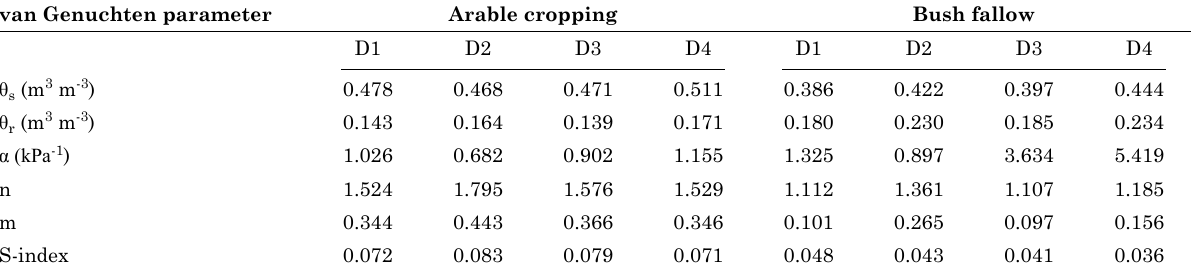
Table 1. van Genuchten parameters obtained from fitting soil water retention data of natural bush fallow and arable cropping systems into the RETC computer program